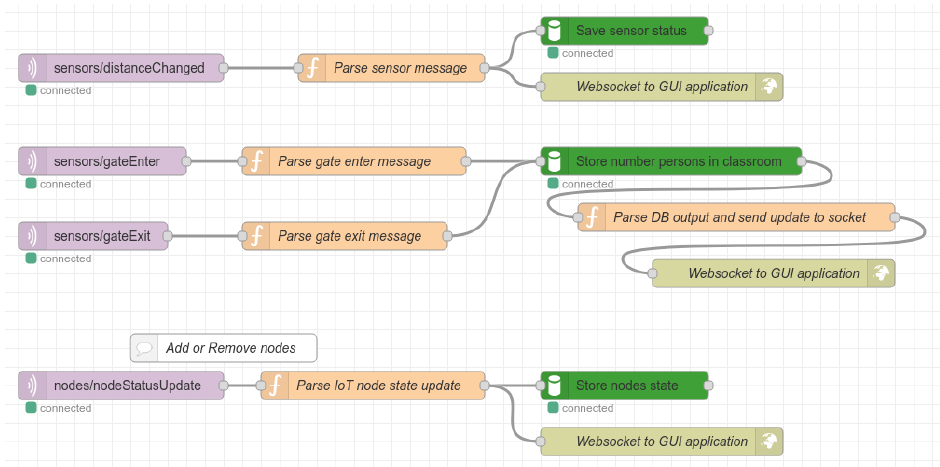
Figure 7. Schematic design of flow for handling incoming